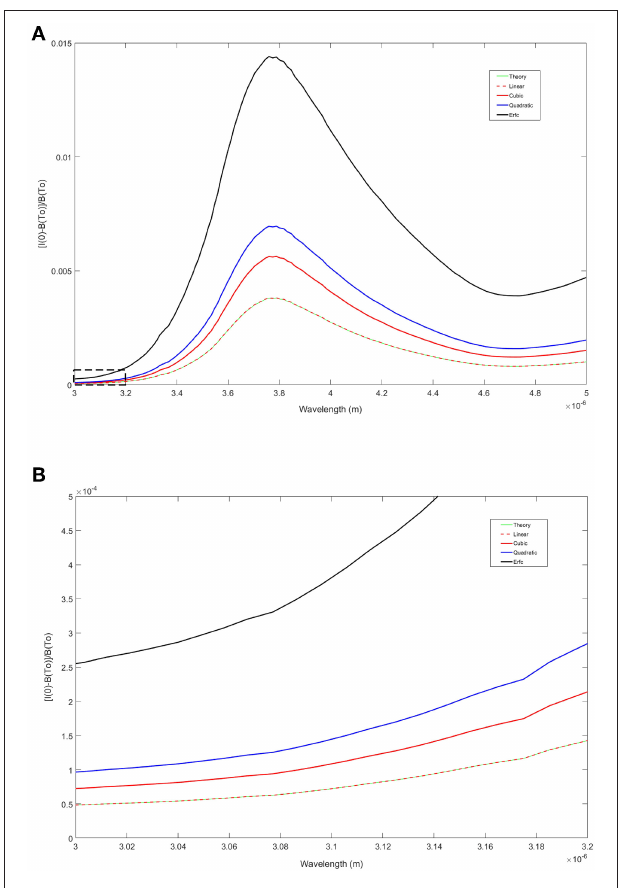
FIGURE 9 | (A) Comparison of MWIR radiation emitted from an air-water surface made dimensionless with the Planck spectrum for several thermal stratifications for a constant surface temperature condition. The dashed box, lower left corner of graph, is the same region in Figure 2A . (B) is a magnified view of the dashed box and the numerical results for the linear profile show very good agreement with the theoretical result.